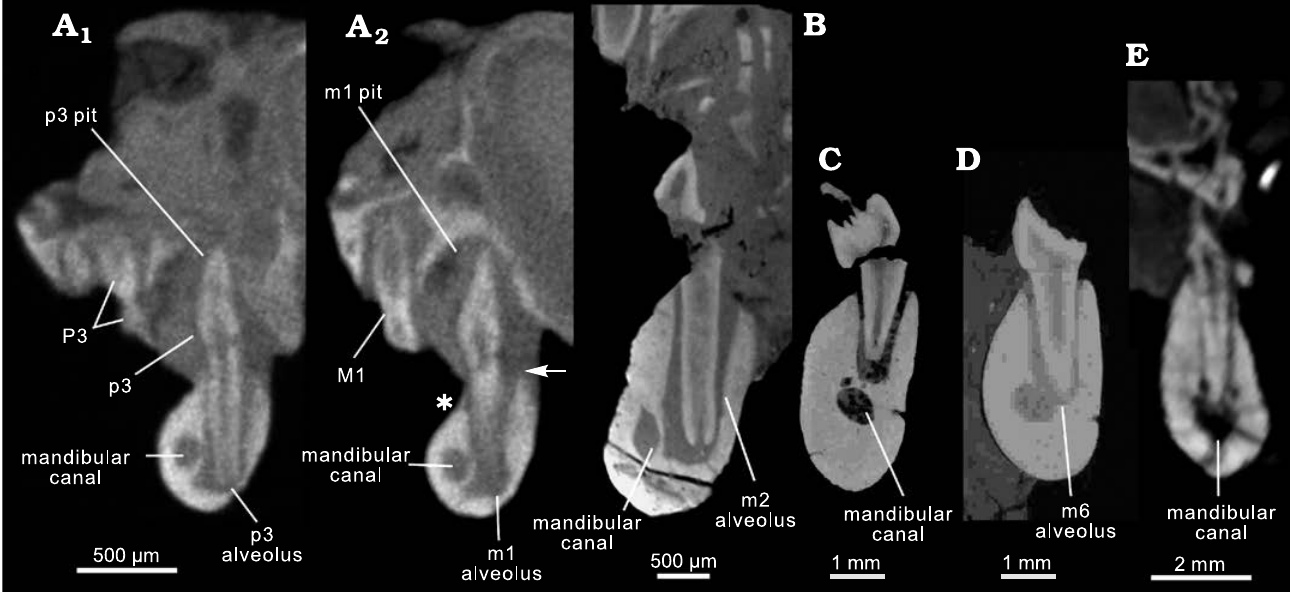
Fig. 5. Comparative morphology of mandibular canals and tooth alveoli in cross sections. A . The mammaliaform Hadrocodium wui Luo, Crompton, and Sun, 2001 (holotype, IVPP 8275) from the Lower Lufeng Formation, Lower Jurassic of Yunnan, China; transverse section of mandible through anterior root of p3 (A 1 ): the main cusp of a tall p3 occludes into its maxillary pit on the palate, and the upper P3 is more lingually inclined than the lower p3; transverse section through anterior root of m1 (A 2 ): the mandibular canal is lateral to the root alveoli of the postcanines; the upper M1 is more inclined lingually than the lower m1; the main cusp of lower m1 occludes into its pit on the palate; the asterisk indicates that the labial alveolar margin is lower on the lingual alveolar margin at the point of the arrow. B . The morganucodontan Morganucodon oehleri Rigney, 1963, (BMNH 2858) from the Lower Lufeng Formation, Lower Jurassic of China; cross section through the anterior root of m2: oval outline with long diameter at 0.25 mm, and short diameter at 0.15 mm; mandibular canal is lateral to the side of roots. C , D . The docodontan Docodon victor Schultz, Bhullar, and Luo, 2019 (as revised by Schultz et al. 2019) from the Morrison Formation, Upper Jurassic of Wyoming, USA. C . YPM 11826, cross section through a root alveolus of m5; mandibular canal cross section in oval outline with the long diameter at 0.8 mm and short diameter at 0.6 mm. D . YPM 11823, mandibular canal cross section through anterior root of m5; circular outline diameter 0.6 mm. The mandibular canal is ventro-lateral to the apices of roots in docodontans. E . The eutriconodontan Juchilestes liaoningensis Gao, Wilson, Luo, Maga, Meng, and Wang, 2009 (DMNH 2607) from the Yixian Formation, Lower Cretaceous of China, as a representative for root canal pattern for crown mammals, in which the mandibular canal is ventral to the root